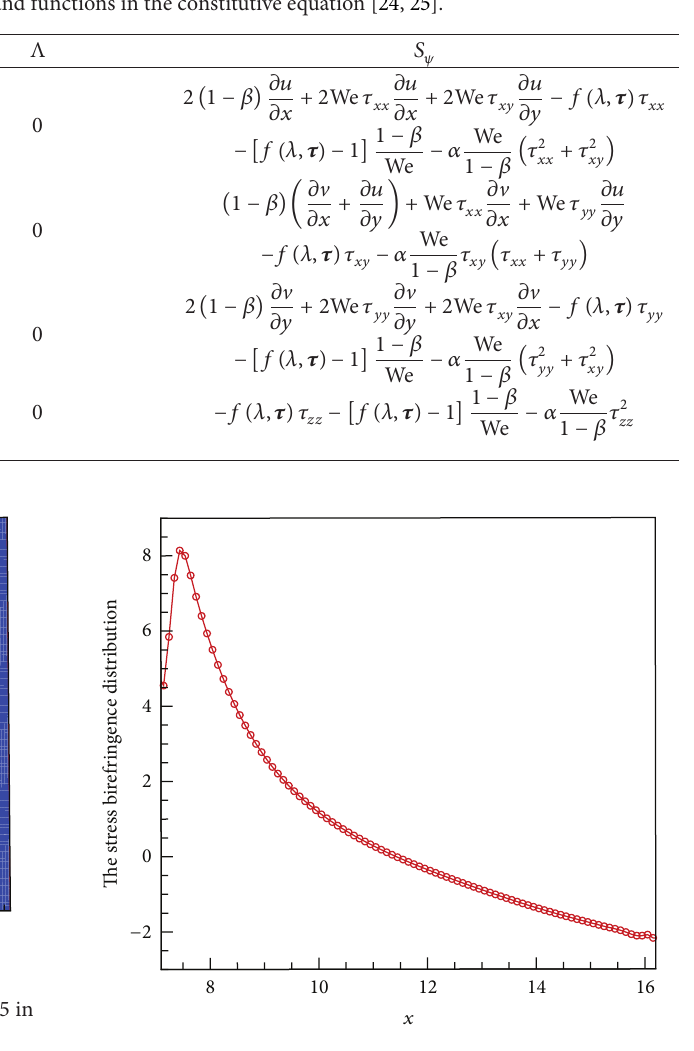
Figure 7: The change of the stress birefringence from the tail of the insert until the end of the